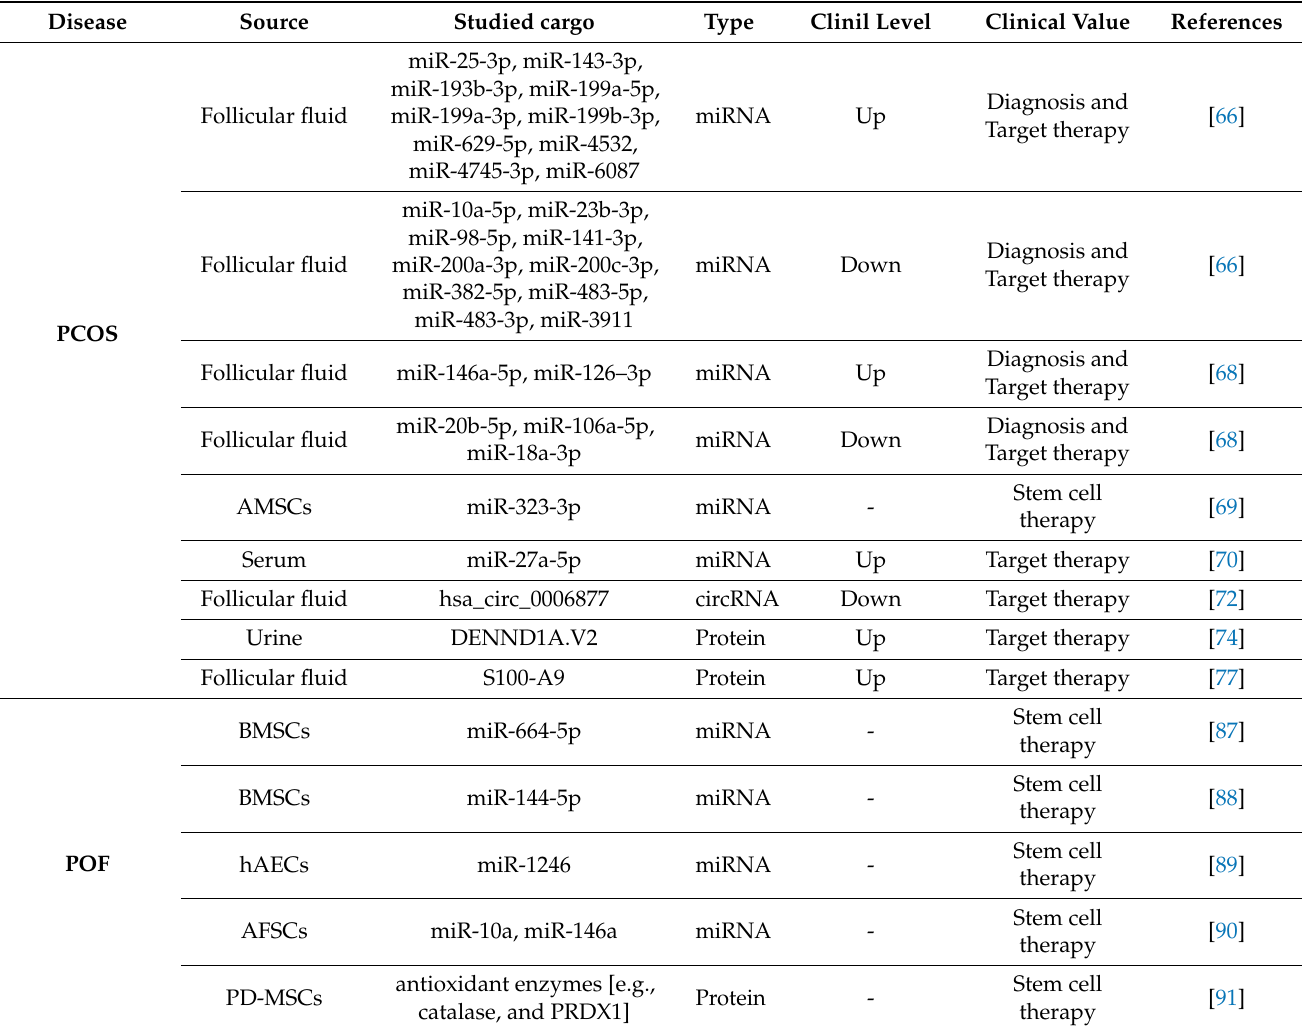
Table 1. A summary of exosomes related to different female reproductive system diseases.